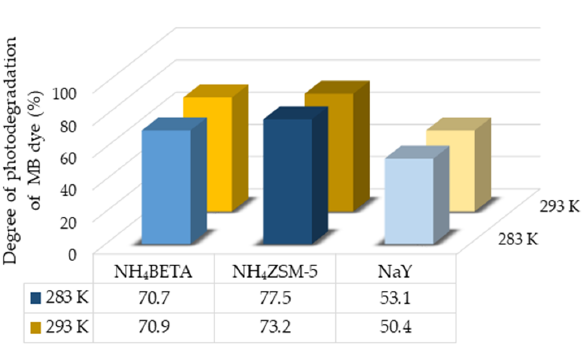
Figure 10. Degree of photodegradation of MB dye in the presence of selected zeolites under the UV radiation at two temperatures after 180